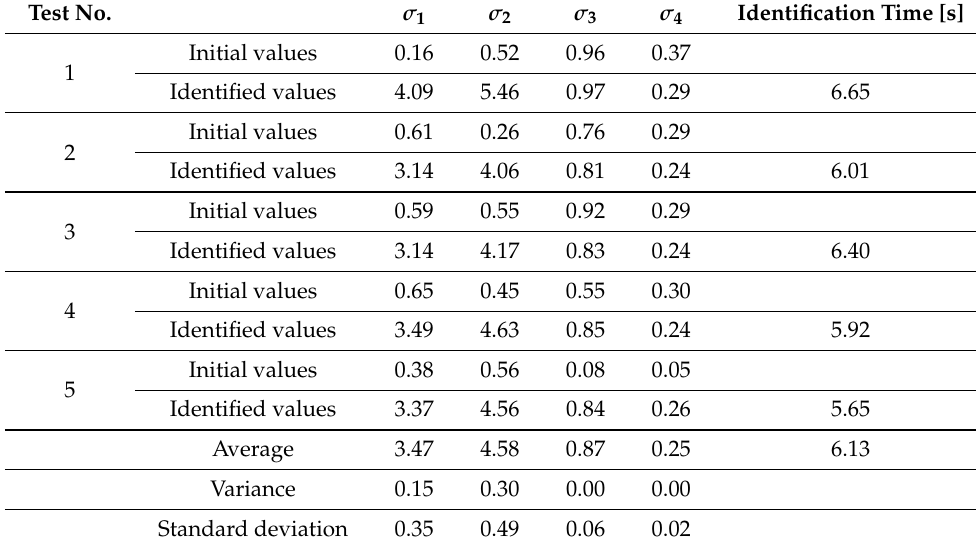
Table 1. Example values of parameters identified by the Levenberg-Marguardt method. Test No. σ